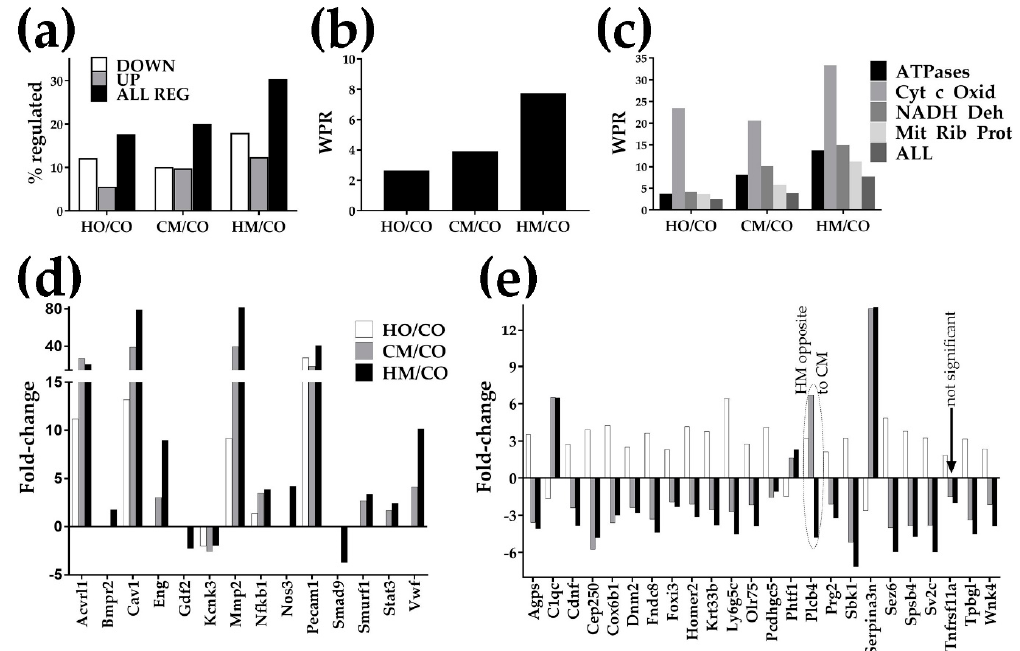
Figure 2. Transcriptomic alterations: ( a ) number of regulated genes; ( b ) weighted pathway regulation of all genes; ( c ) weighted pathway regulation for some important groups of genes. Pathways: Cyt c Oxid = cytochrome c oxidases, NADH Deh = NADH dehydrogenases, Mit Rib Prot = mitochondrial ribosomal proteins. Note that Cyt c Oxid was by far the most altered group of respiratory genes. HO / CO, CM / CO, HM / CO = expression fold-change (negative for downregulation) in the indicated comparison; ( d ) statistically significant fold-changes of genes whose altered structure and / or expression is often associated with PH. Genes: Acvrl1 (activin A receptor type II-like 1), Bmpr2 (bone morphogenetic protein receptor, type II (serine / threonine kinase)), Cav1 (caveolin 1, caveolae protein), Eng (endoglin), Gdf2 (growth di ff erentiation factor 2), Kcnk3 (potassium channel, subfamily K, member 3), Mmp2 (matrix metallopeptidase 2), Nfkb1 (nuclear factor NF-kappa-B p105 subunit), Nos3 (nitric oxide synthase